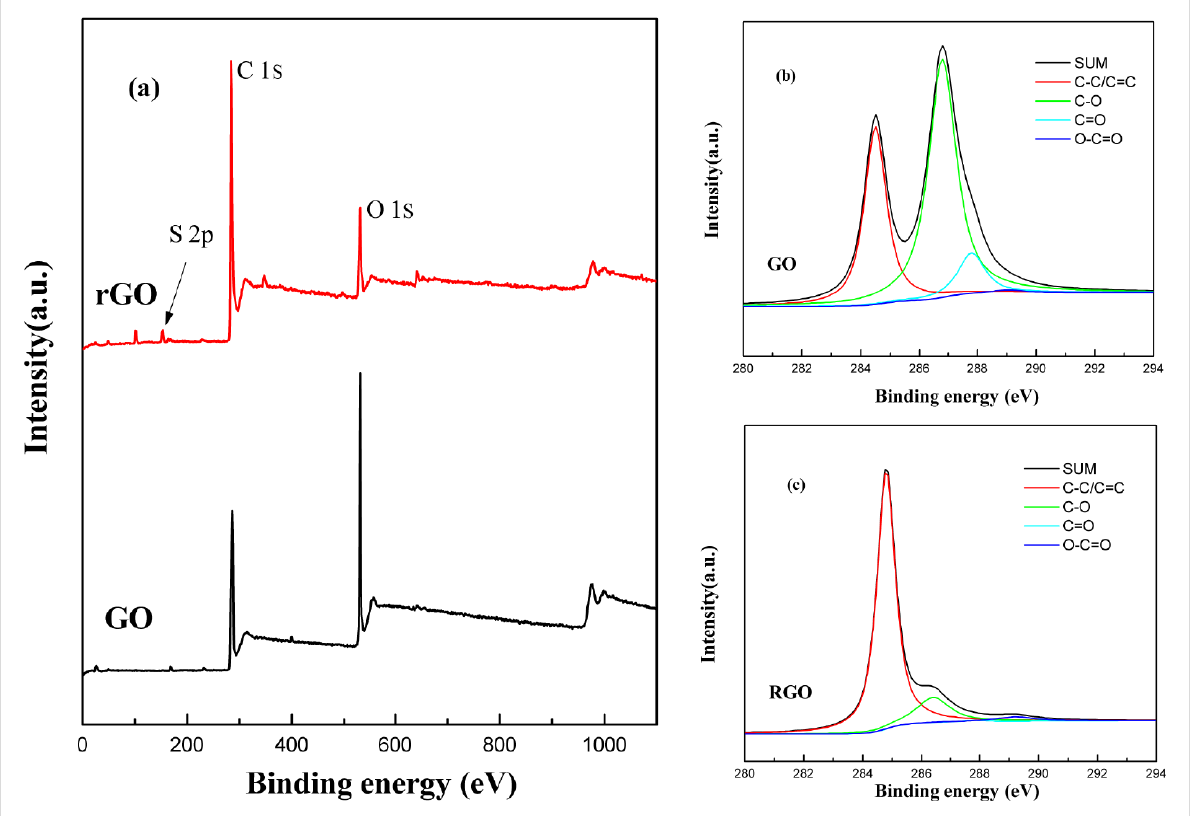
Figure 5: X-ray photoelectron spectrometry spectra and deconvolution of (a) survey scans, and C 1s high-resolution spectra of (b) GO and (c)